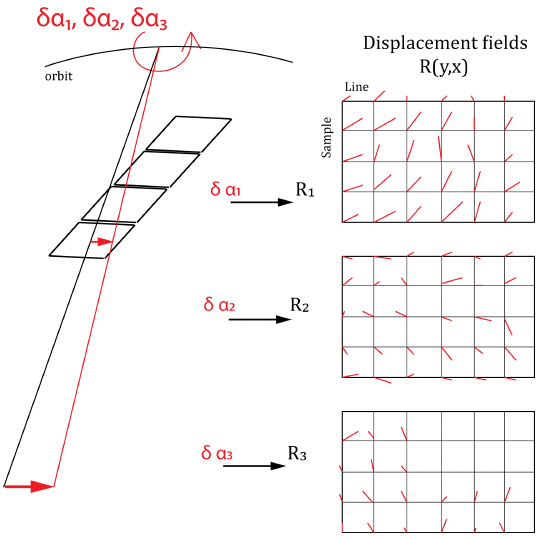
Figure 1: The relationship between the change in sensor attitude δα i , and the arising 2D pixel displacements R i